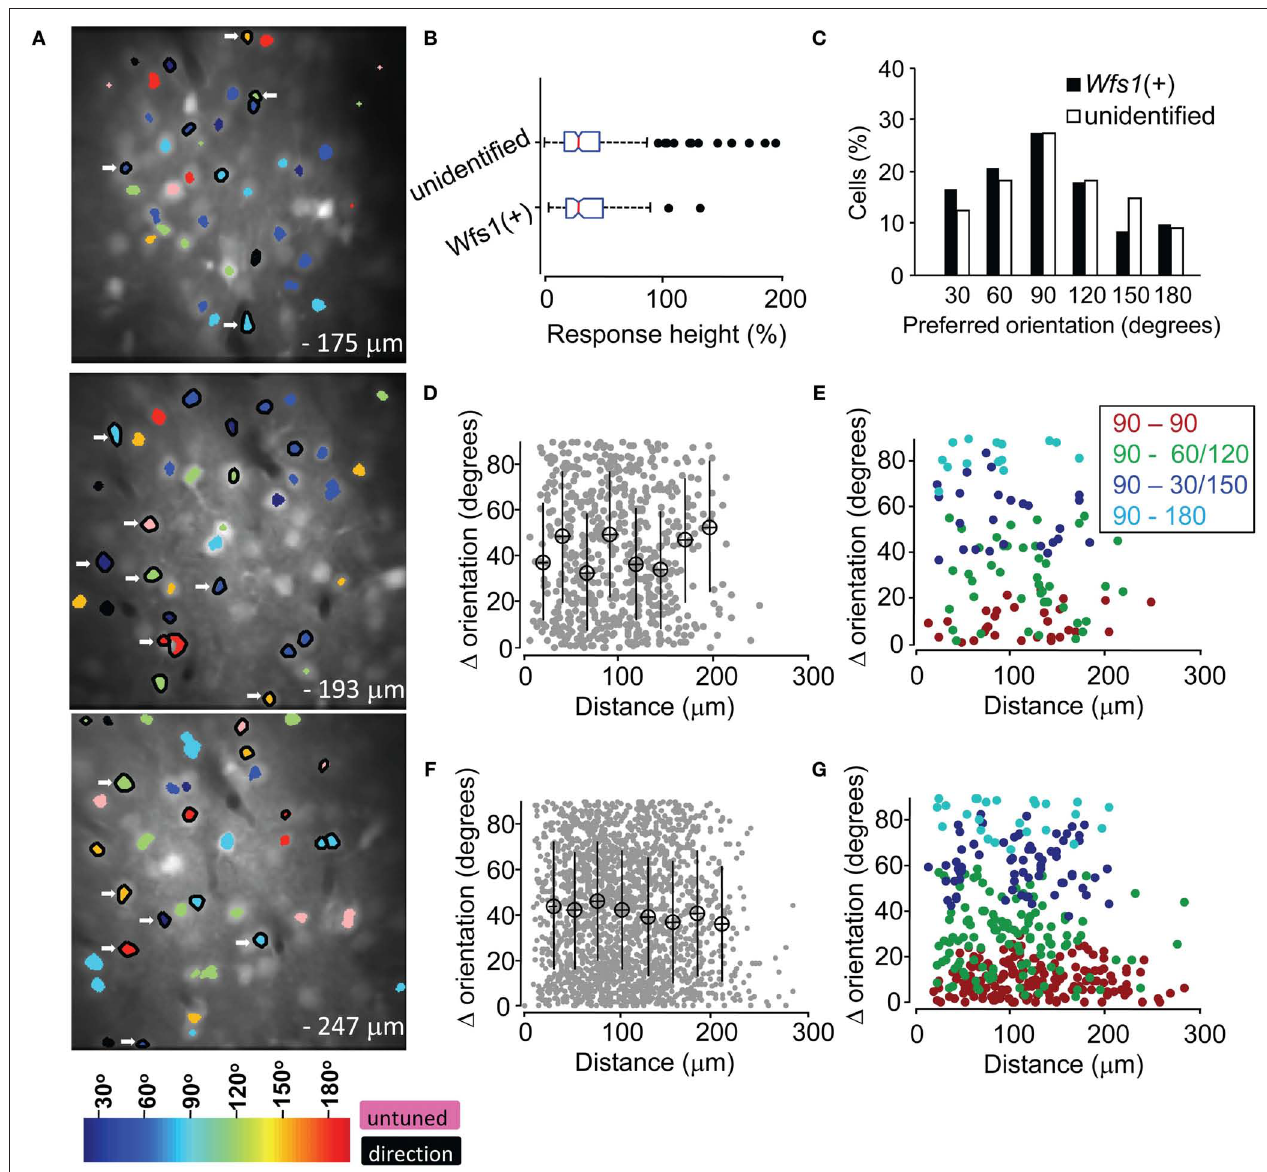
orientation angle preference between pairs of Wfs1 ( + ) cells (data pooled from four experimental mice). Mean ± SD of distance and orientation angle difference within a 20-μm bin is plotted. (e) Difference in orientation angle preference between pairs of Wfs1 ( + ) cells sub-categorized by the bin center in (C) . Legend denotes pairwise comparison between cells according to their preferred orientations. (F) Difference in orientation angle preference between pairs of Wfs1 ( + ) cells and unidentified cells [data pooled from four experimental mice also shown in (D) ]. Mean ± SD of distance and orientation angle difference within a 20-μm bin is plotted. (G) Difference in preferred angle between pairs of Wfs1 ( + ) cells and unidentified cells sub-categorized by the bin center in (C) . Legend denotes pairwise comparison between cells according to their preferred